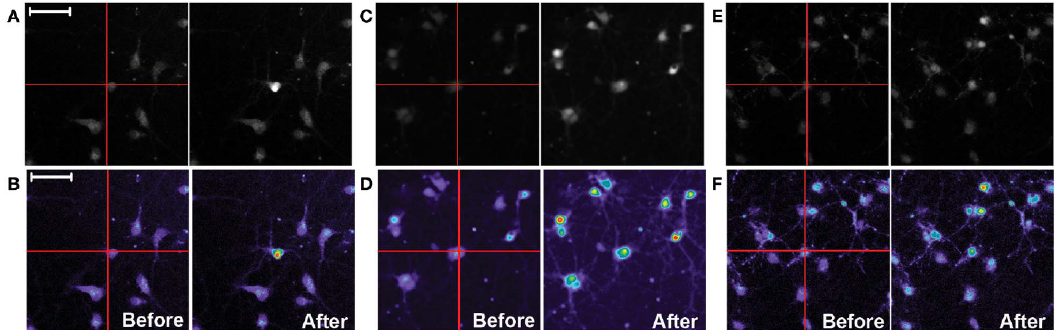
Figure 4. Fluo-4 calcium fluorescence images of rat primary cortical cells stimulated from the top-side by light-addressable electrodes with different semiconductor materials: ( A,B ) polished silicon, ( C,D ) porous oxidized silicon, and ( E,F ) porous carbonized silicon. On the left side of each group of four images, the grayscale image (top) and related heatmap image (bottom) before stimulation with a laser source is shown, while on the right side, the images of the stimulated neurons are depicted. The scale bar indicates 50 µ m. Adapted from Reference [64] under the CC BY